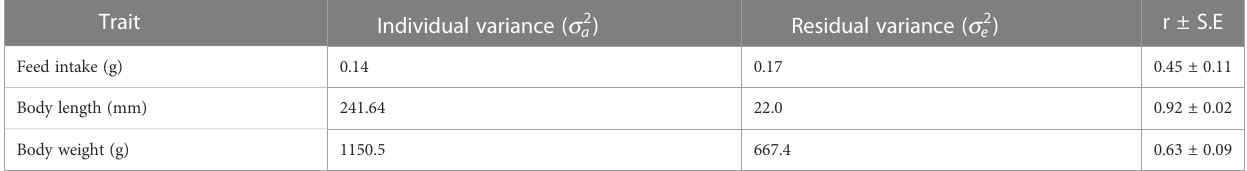
TABLE 4 Variance components and repeatability (r) for feed intake, body length, and body weight of Atlantic salmon over 70 days.